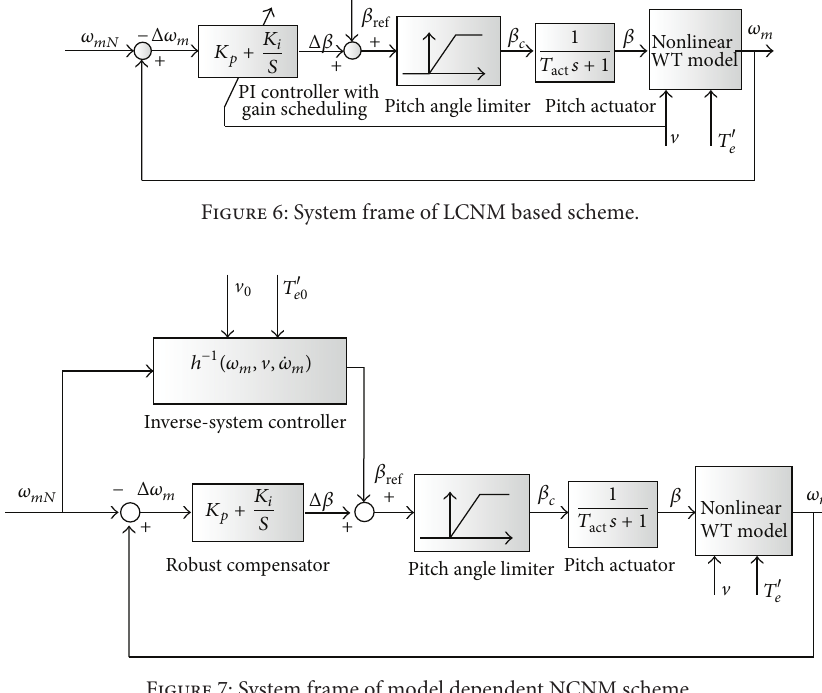
Figure 7: System frame of model dependent NCNM